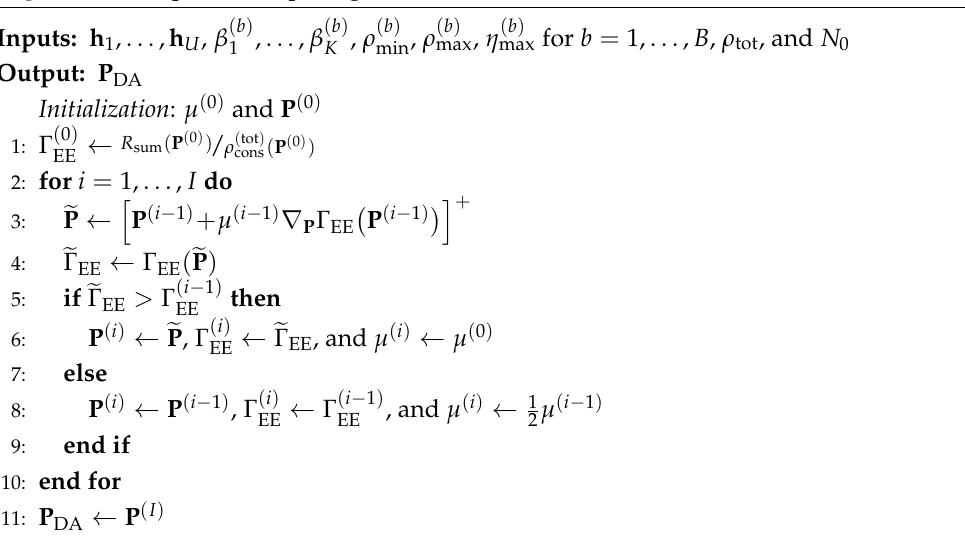
Algorithm 1 Steps for computing P DA